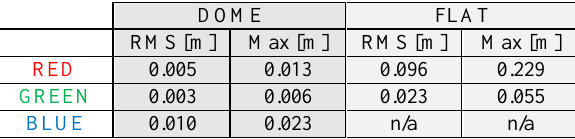
Table 3. Summary of the relative comparison between 3D coordinates obtained from the single R,G,B channels and the one obtained as RGB combination for each port.